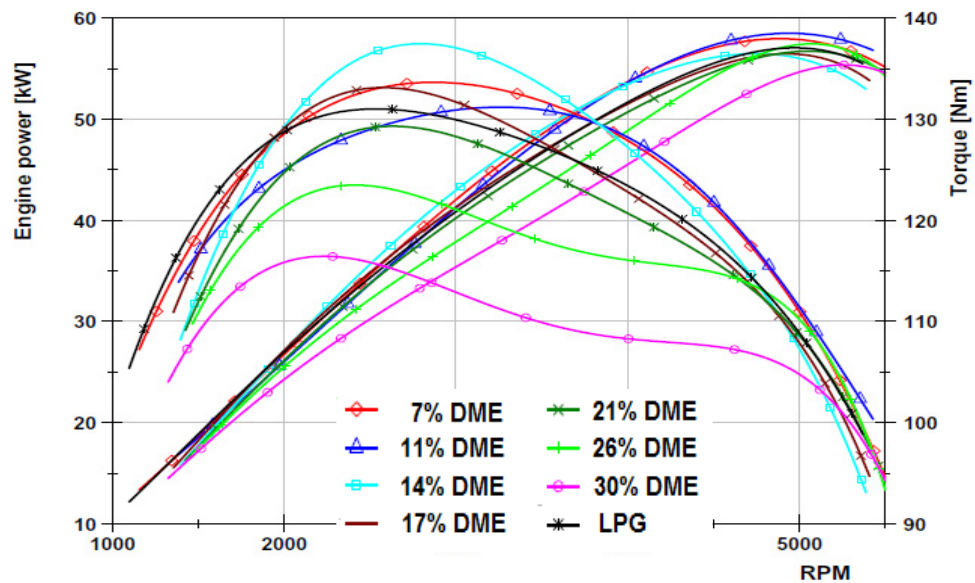
Figure 2. Engine torque and power curves for various mass fractions of DME at WOT.